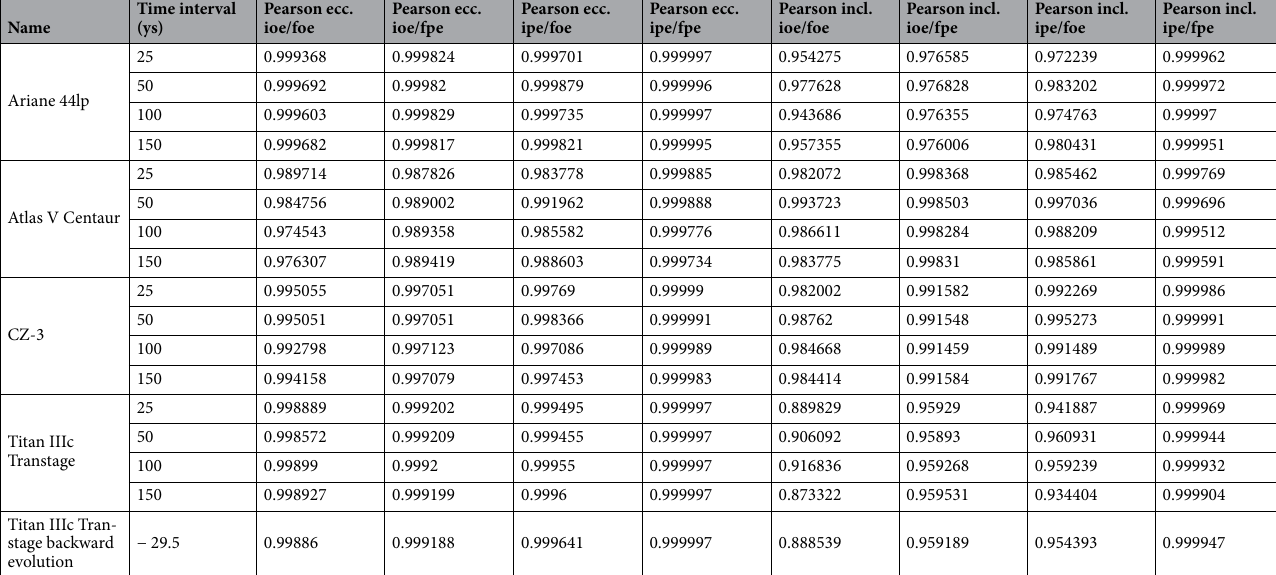
Table 3. The Pearson correlation coefficient obtained propagating forward in time between the initial osculating elements (ioe) and the final osculating elements (foe), between the initial osculating elements (ioe) and the final proper elements (fpe), between the initial proper elements (ipe) and the final osculating elements (foe), and between the initial proper elements (ipe) and the final proper elements (fpe) for eccentricity (ecc.) and inclination (incl.) at different final times (25, 50, 100, and 150 years). The last row refers to an example where we back-propagate in time.